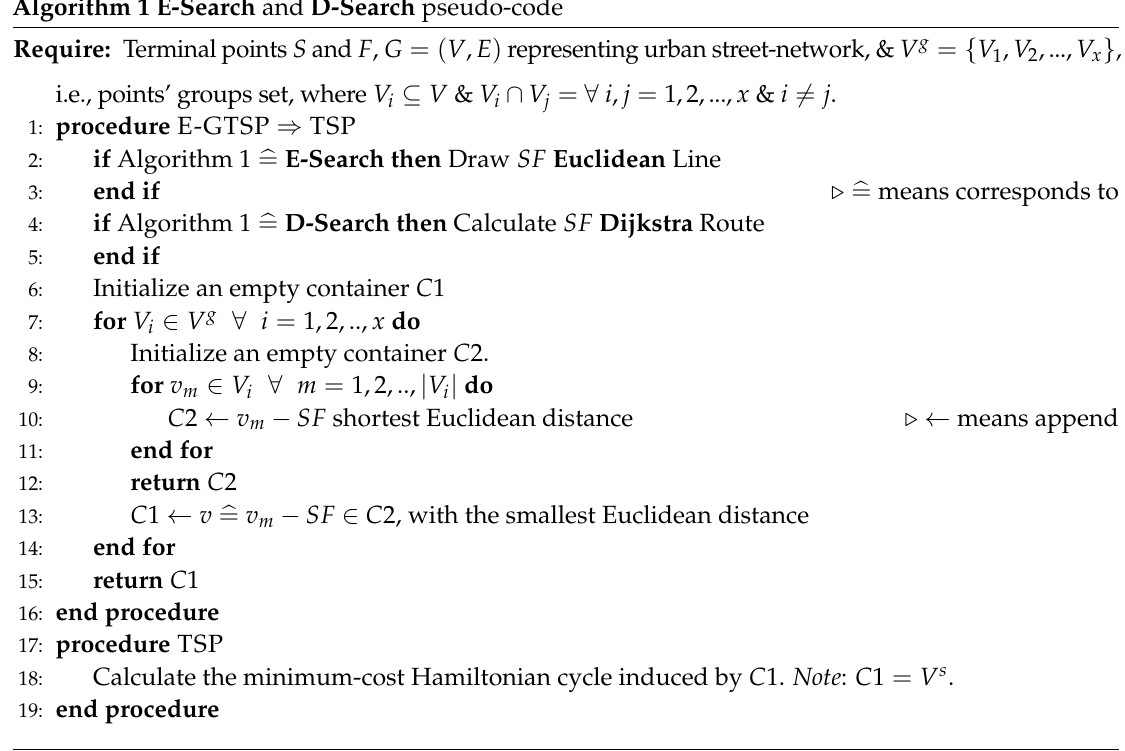
Algorithm 1 E-Search and D-Search